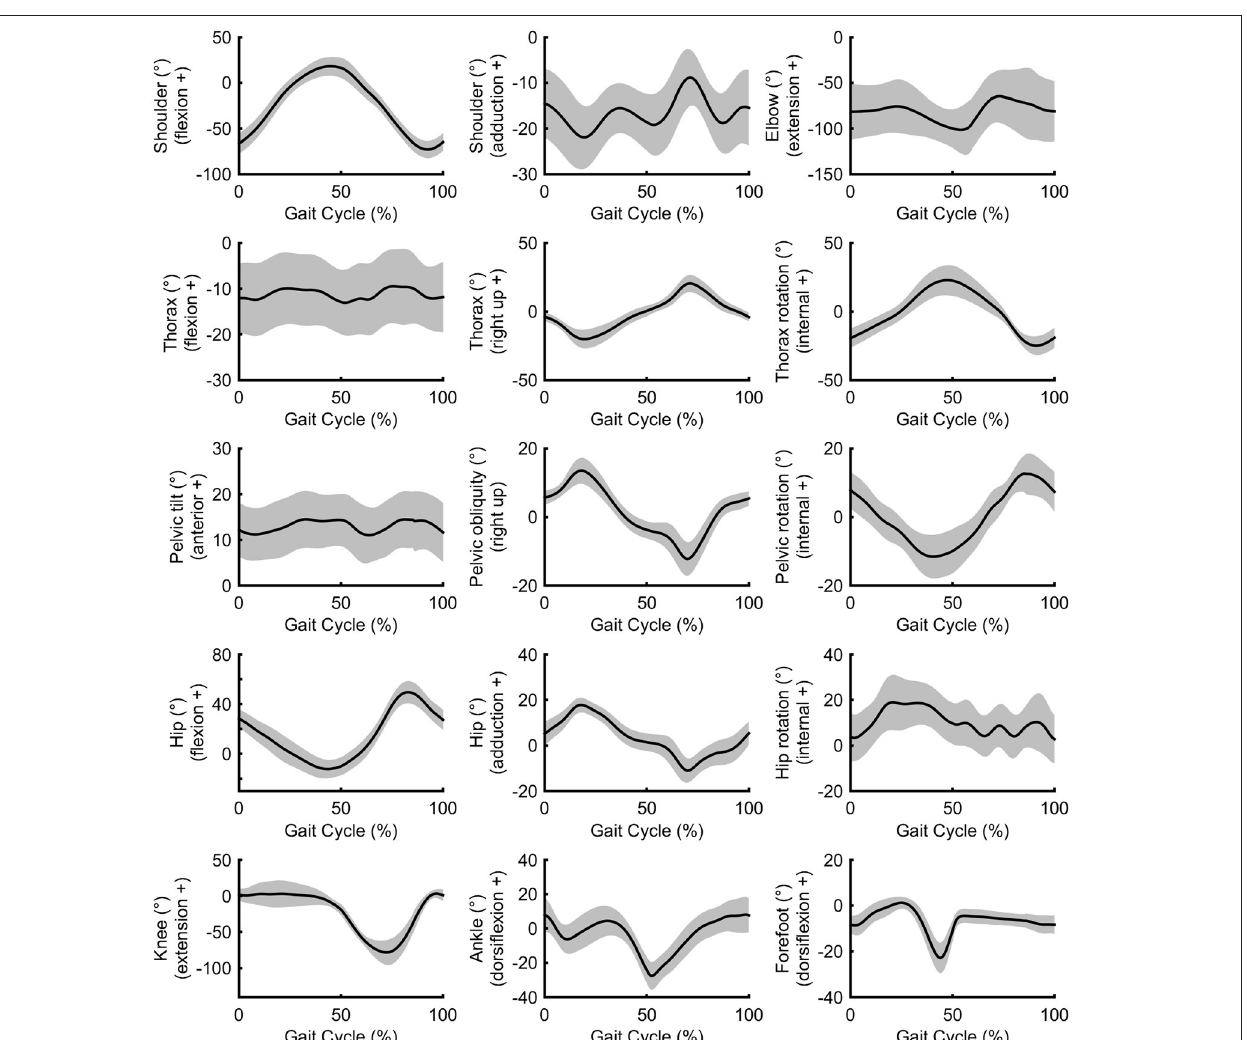
Frontiers in Sports and Active Living |